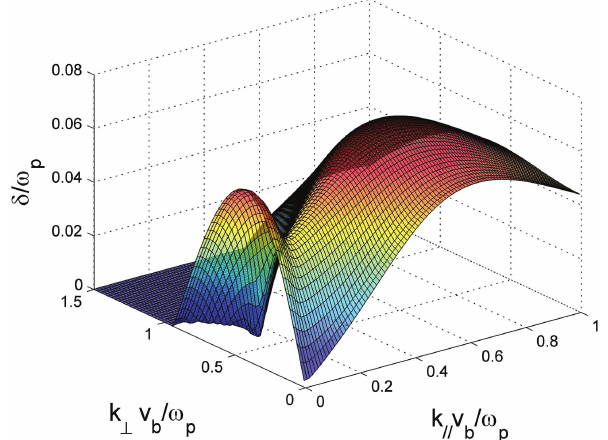
Fig. 3. Growth-rate map accounting for Maxwell-J¨uttner distri- bution functions, with γ b = 1 . 2 and n b = n p , T b = 500keV and T p = 5keV.